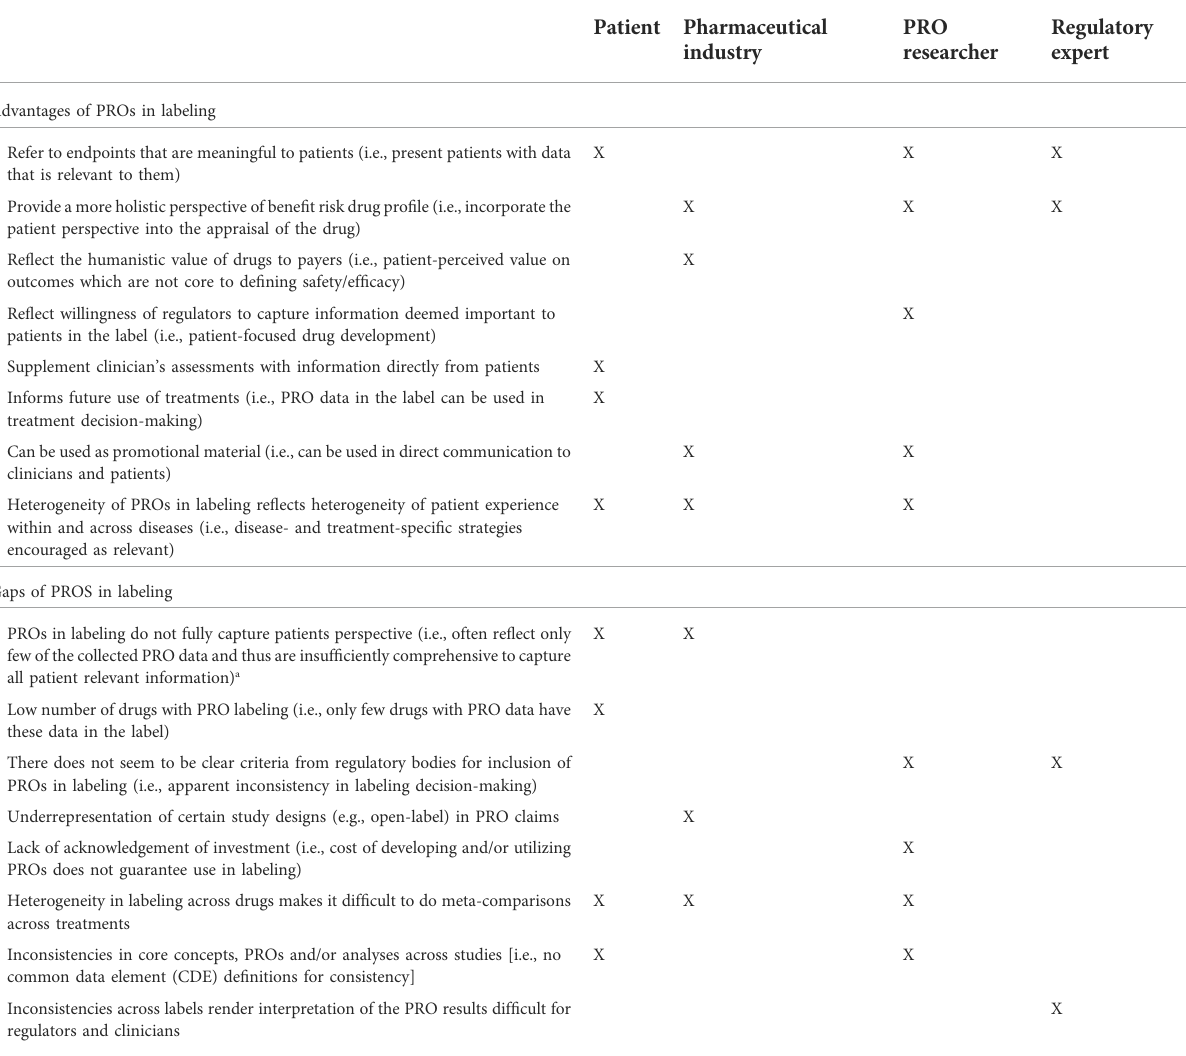
TABLE 3 Advantages and gaps of PRO data in drug labeling from different